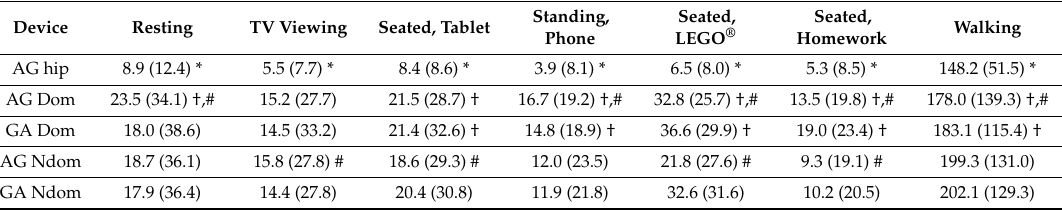
Table 4. Accelerometer output [mean (SD)] from ActiGraph (AG) and GENEActiv (GA) monitors, expressed in mg, across all stations ( n =